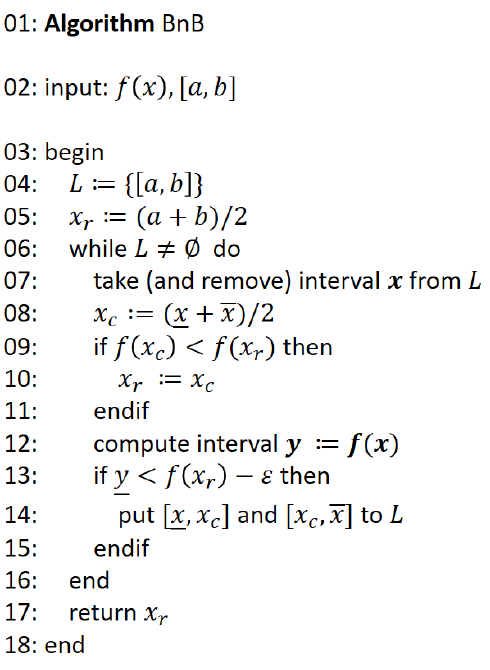
Figure 2. The standard branch-and-bound